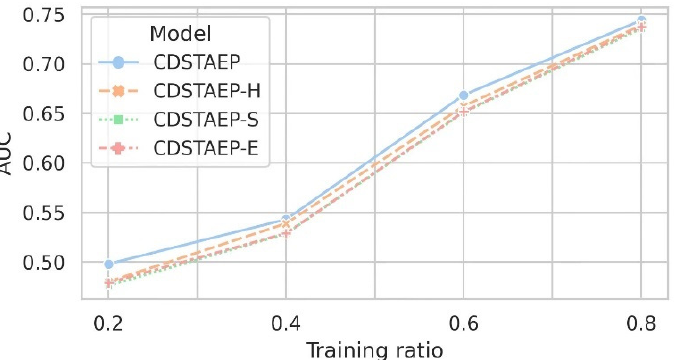
Figure 7. Comparison of the effects of different representation spaces on event prediction: the horizontal axis is the ratio of the training set, and the vertical axis is the AUC score. Table 6. AUC for prediction by different representation spaces on the